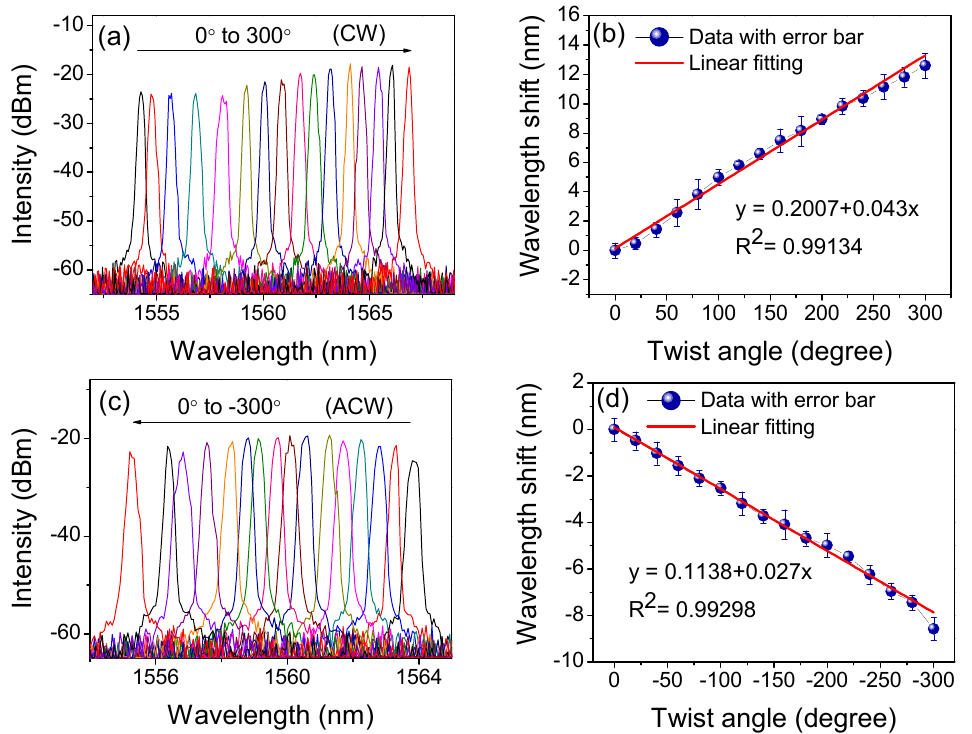
Figure 9. ( a ) Twist-induced lasing-wavelength shift and ( b ) response in the CW direction; Figure 9. (a) Twist-induced lasing-wavelength shift and (b) response in the CW direction; (c) Twist- ( c ) Twist-induced lasing-wavelength shift and ( d ) response in the ACW induced lasing-wavelength shift and (d) response in the ACW direction.